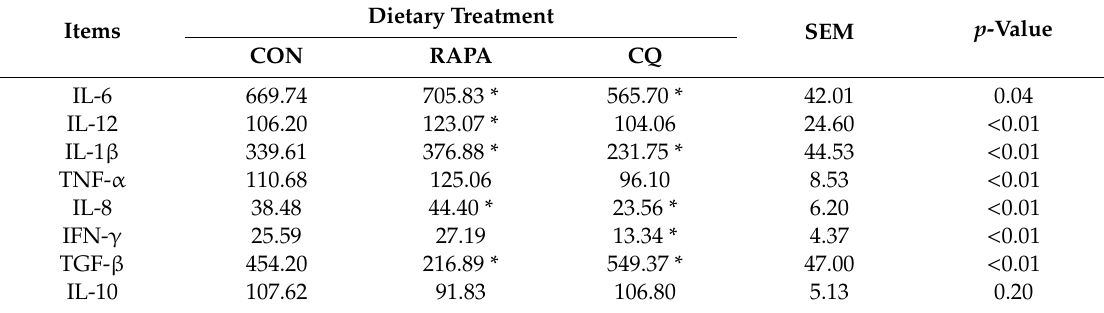
Figure 4. Serum immune factors levels of IgG and IgM. Dietary treatment: RAPA, rapamycin; CQ, chloroquine; CON, normal saline. Data are expressed as means ± SEM ( n = 6), all values are expressed in relation to the control. * p < 0.05 vs. control. Table 4. Serum inflammatory factors levels (pg / mL).